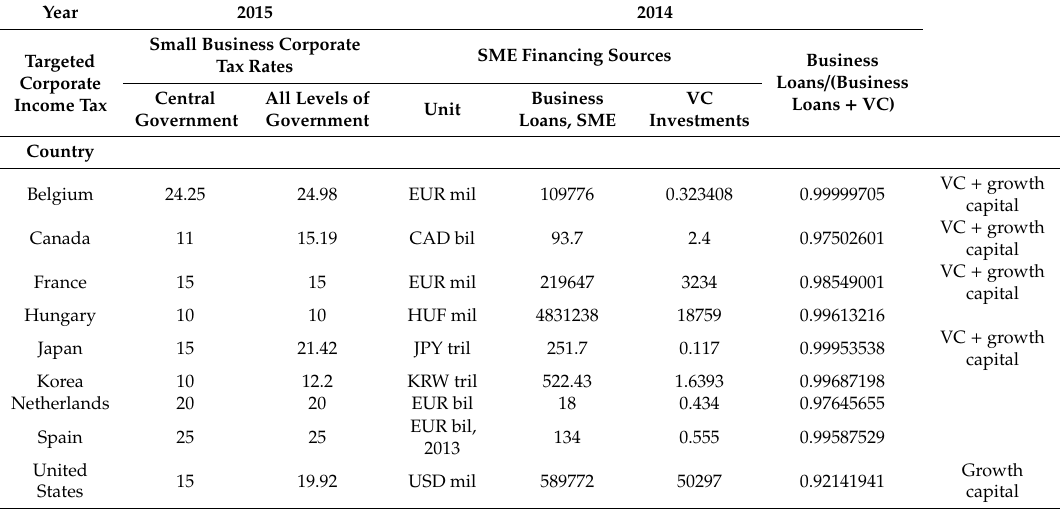
Table 6. International debt and tax rates for SMEs.